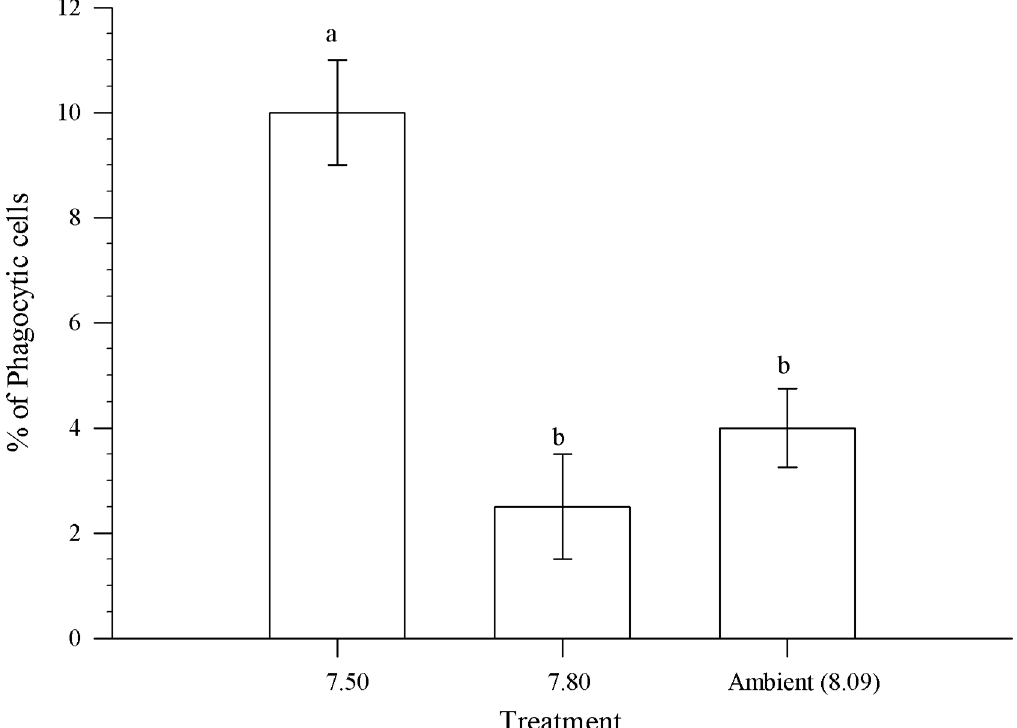
Fig 4. The percentage of phagocytic hemocytes in Chionoecetes bairdi , Tanner Crab, from each pH treatment. The error bars represent the standard error and a different letter indicates a significant difference between treatments.